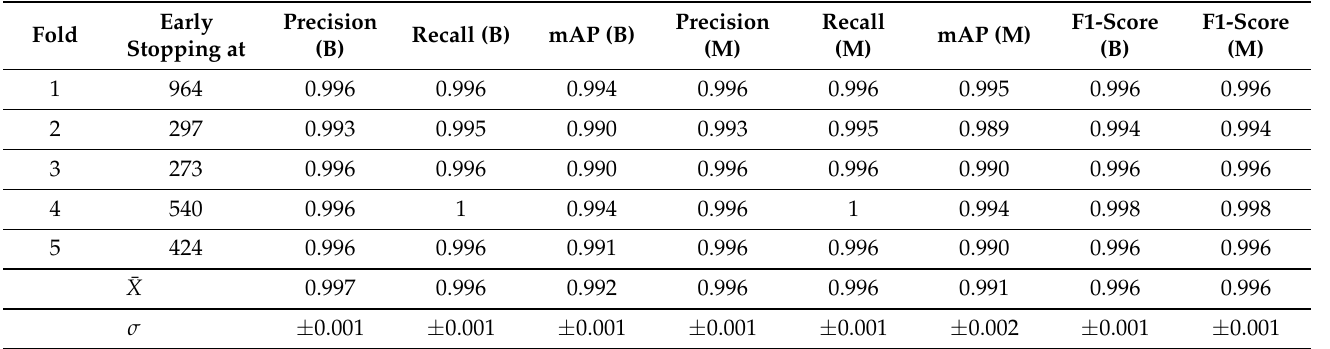
Table 6. Results for YOLOv5s